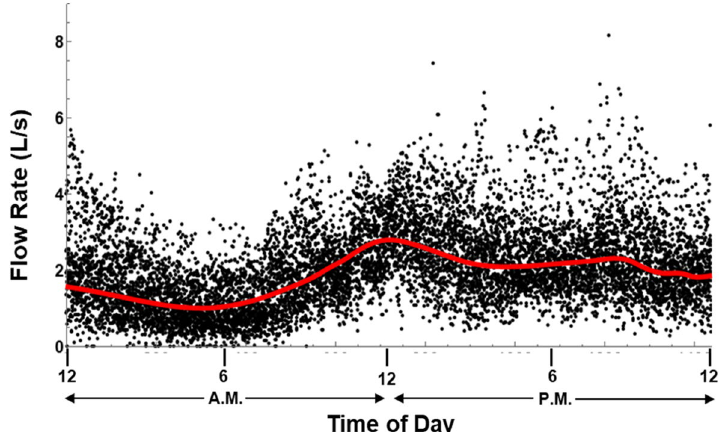
Fig. 2 Merged flow data with mean trend line (OU community of